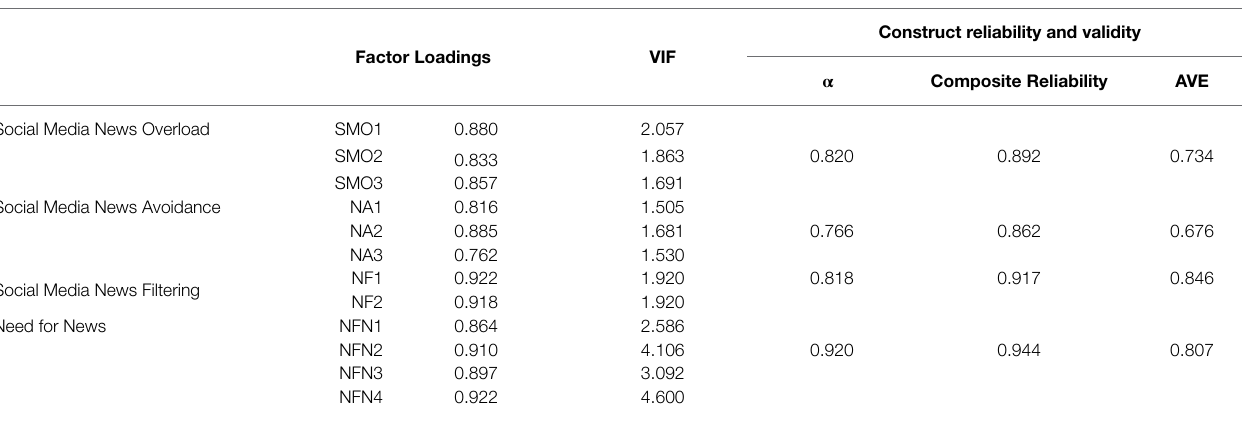
TABLE 2 | Model assessment (direct model).